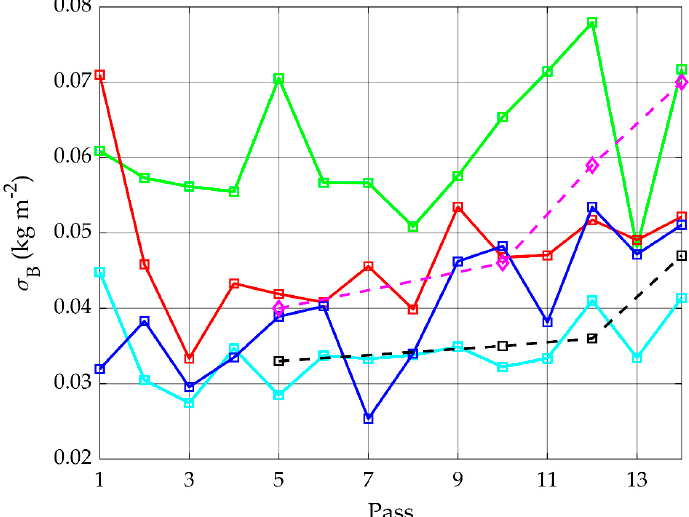
Figure 15. Estimation error for biomass B obtained from models B = B 0 + µ ρ H (cyan), B = c 0 R 0 + c 1 R 1 (green), B = c 0 H + c 1 R 1 (red), and B = c 0 H + c 1 R 1 + c 2 R 2 (blue) for the 14 passes from Transect 3. Also shown are the model B = B 0 + μ ρ H (black squares, dashed line) and B = c 0 H + c 1 R 1 (magenta diamonds, dashed line) from Transect 2.